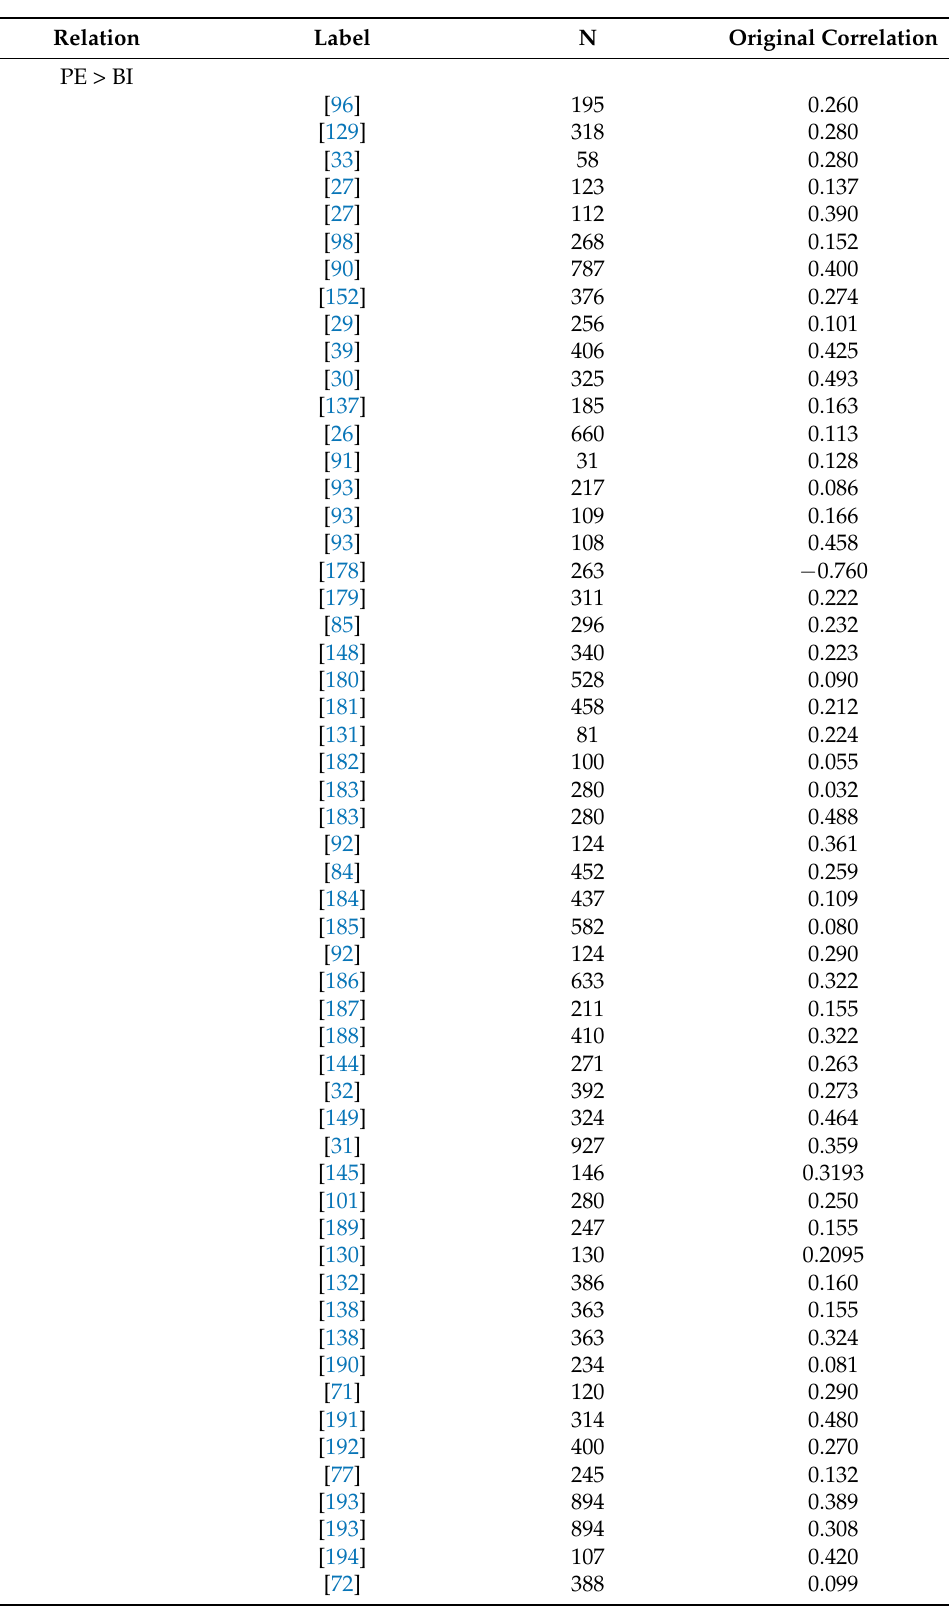
Table A1. List of Correlations Considered in the